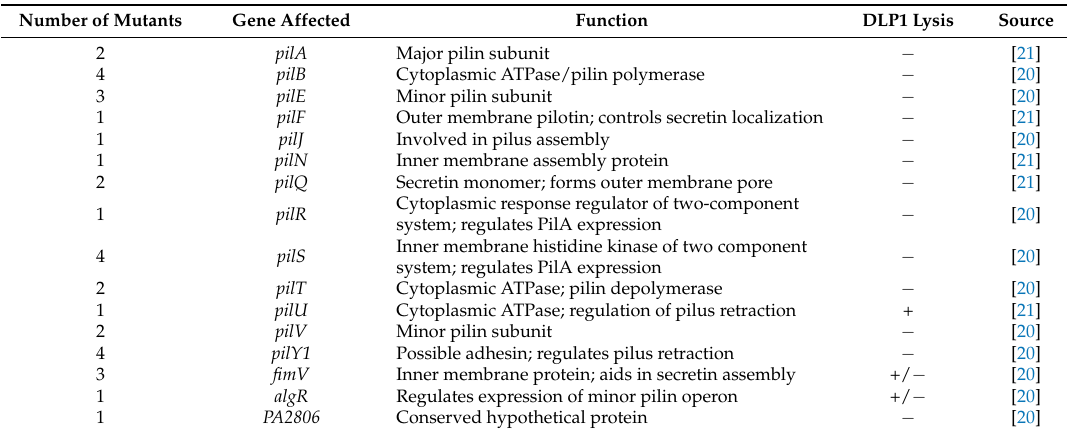
Table 2. P. aeruginosa PA01 genes involved in type IV pilus biogenesis and DLP1 phage infection identified by a transposon mutant library